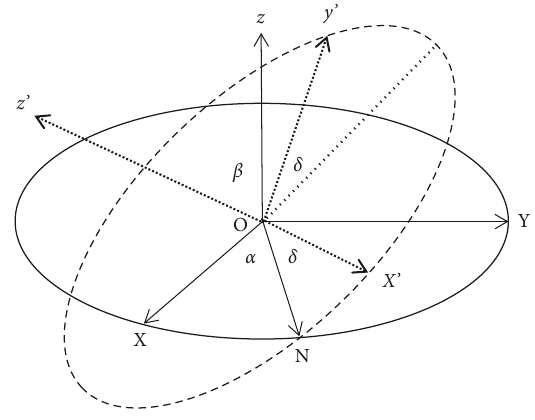
Figure 2: Euler angle rotation coordinate system.